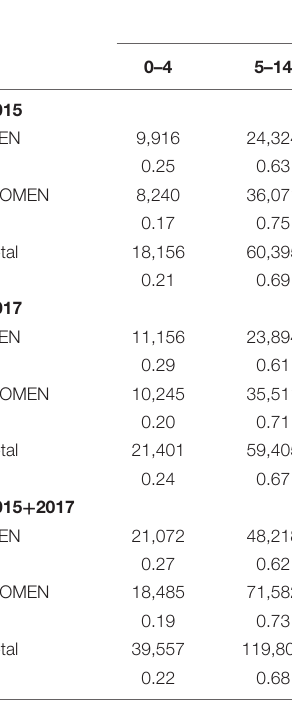
TABLE 5 | Consumption of PGX drugs per sex and specific age